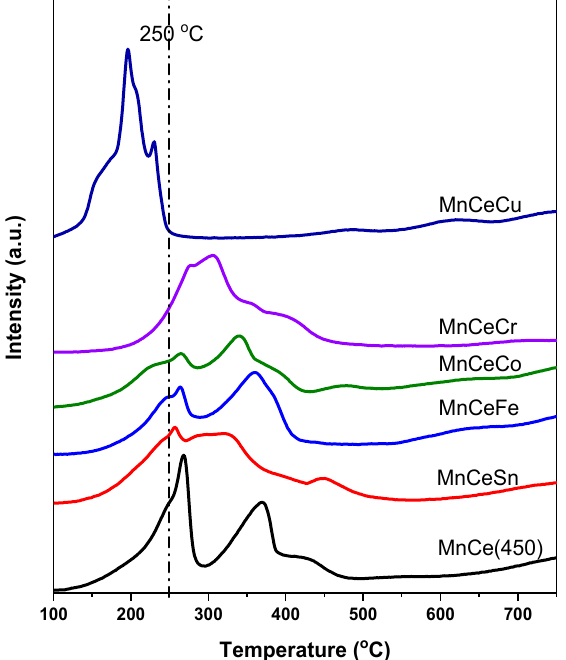
Figure 2. H 2 -TPR profiles of MnCe(450), MnCeSn, MnCeFe, MnCeCo, MnCeCr, and MnCeCu.